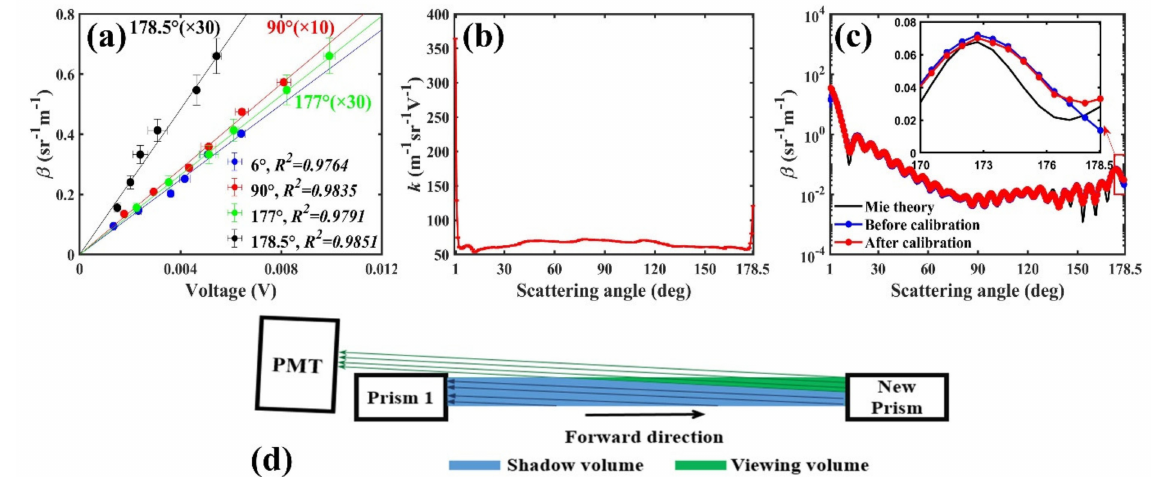
Figure 5. ( a ) Scatterplot between raw signal voltage measured by VSFlab and calculated VSF for 0.203 µ m bead solutions with various concentrations at four scattering angles of 6 ◦ (blue dots), 90 ◦ (red dots), 177 ◦ (green dots) and 178.5 ◦ (dark dots). The values (voltage and β ) at 90 ◦ , 177 ◦ , and 178.5 ◦ are multiplied by 10, 30, and 30 for an unambiguous presentation. The four lines are the results of applying a robust linear regression model. R 2 for the four angles are 0.9764, 0.9835, 0.9791, and 0.9851 respectively. Horizontal and vertical error bars represent standard deviations estimated, respectively, from the 30 measurements of Voltage ( θ ) at each concentration and β calculated by accounting Mie for uncertainties in the mean diameter of the beads and measured c . ( b ) Calibration coefficients k for each angle at 532 nm. ( c ) Comparison of VSFs for 3 µ m beads before amplitude calibration and after amplitude calibration. In order to facilitate comparison with the calibrated scattering signal, the scattering signal before calibration was multiplied by the average k between 3 ◦ and 177 ◦ . ( d ) A schematic of the shadow effect. The blue region represents the scattering volume from which the scattering light is shadowed by prism 1. The green region represents the scattering volume from which the scattering light is received by the